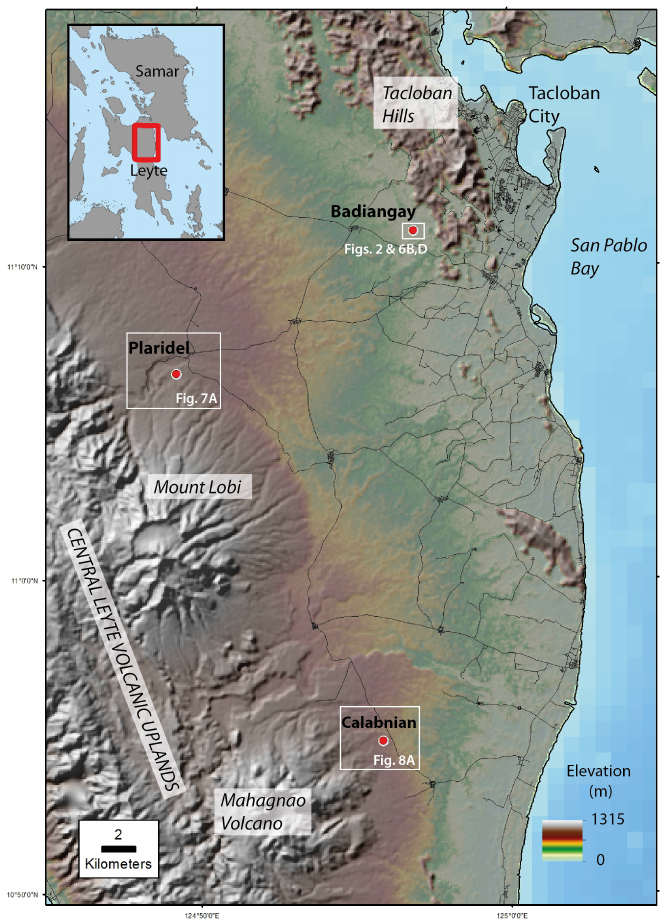
Figure 1. Location of the three case studies in the Philippines on the island of Leyte to the South-West of Tacloban, where typhoon Haiyan made landfall. The background elevation data is from NASA Shuttle Radar Topography Mission (STRM)